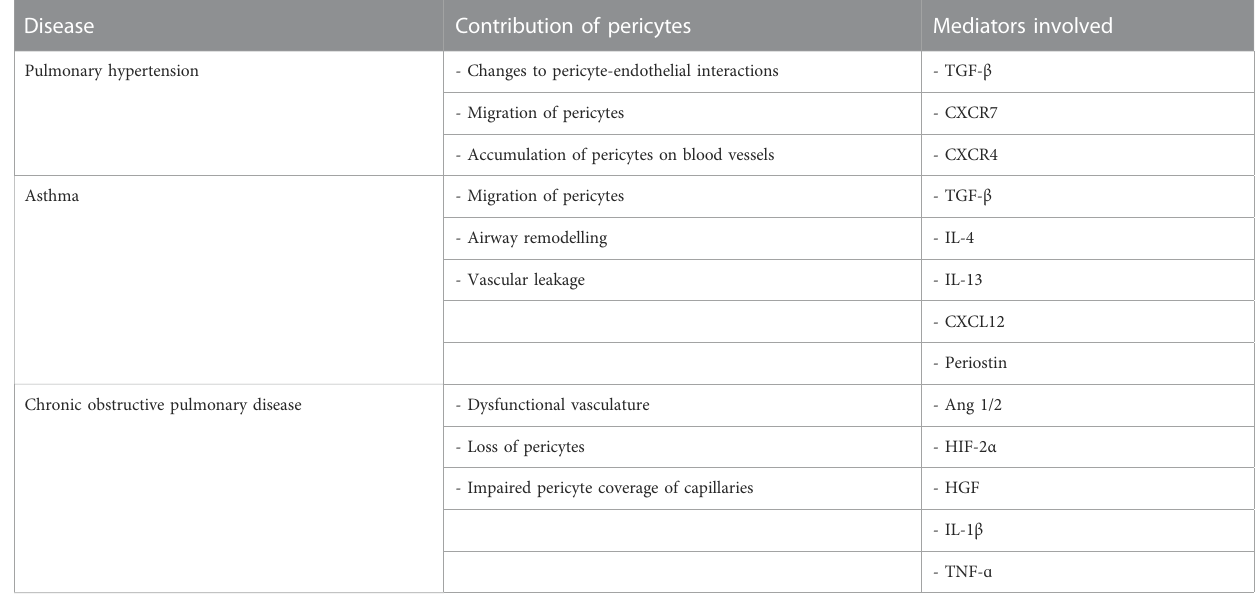
TABLE 1 Summary of the contribution of pericytes to pulmonary diseases as well as the key compounds